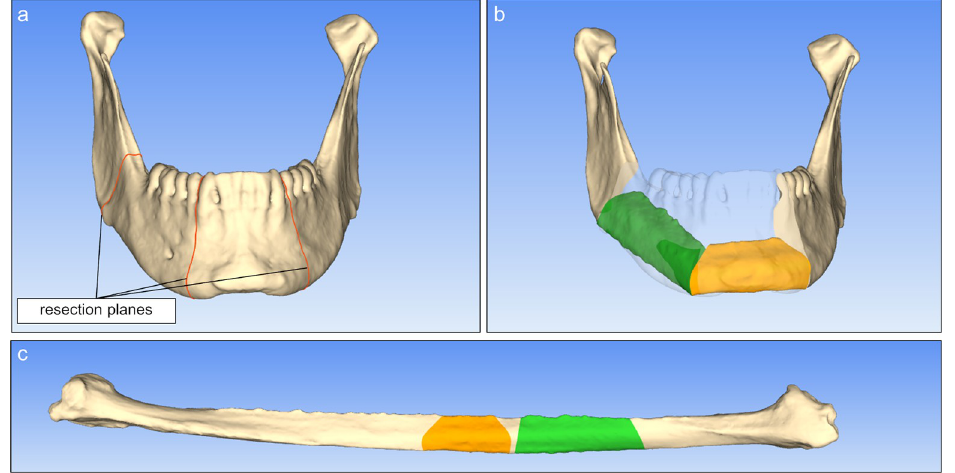
Fig 1. Virtual reconstruction planning with a custom-made, newly developed software tool. Patient specific 3D models of mandibula and fibula are used. (a) Resection planes are adjusted freely for the mandible by the surgeon. (c) Fibula segments are automatically projected into (b) the defect and can be adjusted for optimal harvesting